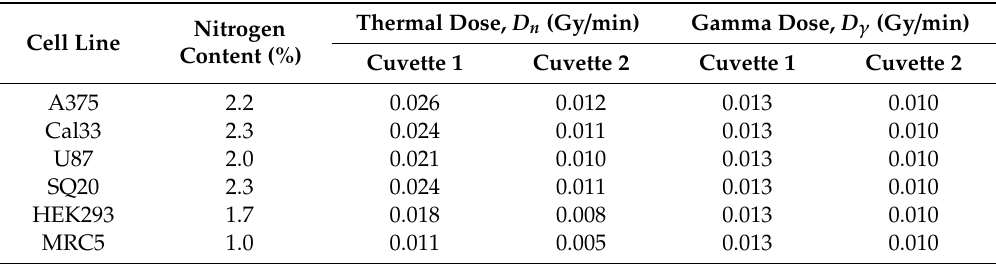
Table 1. Nitrogen content and dose components of the cell lines irradiated using the PF1B neutron beam instrument at the Institut Laue-Langevin (ILL). Campaign of June